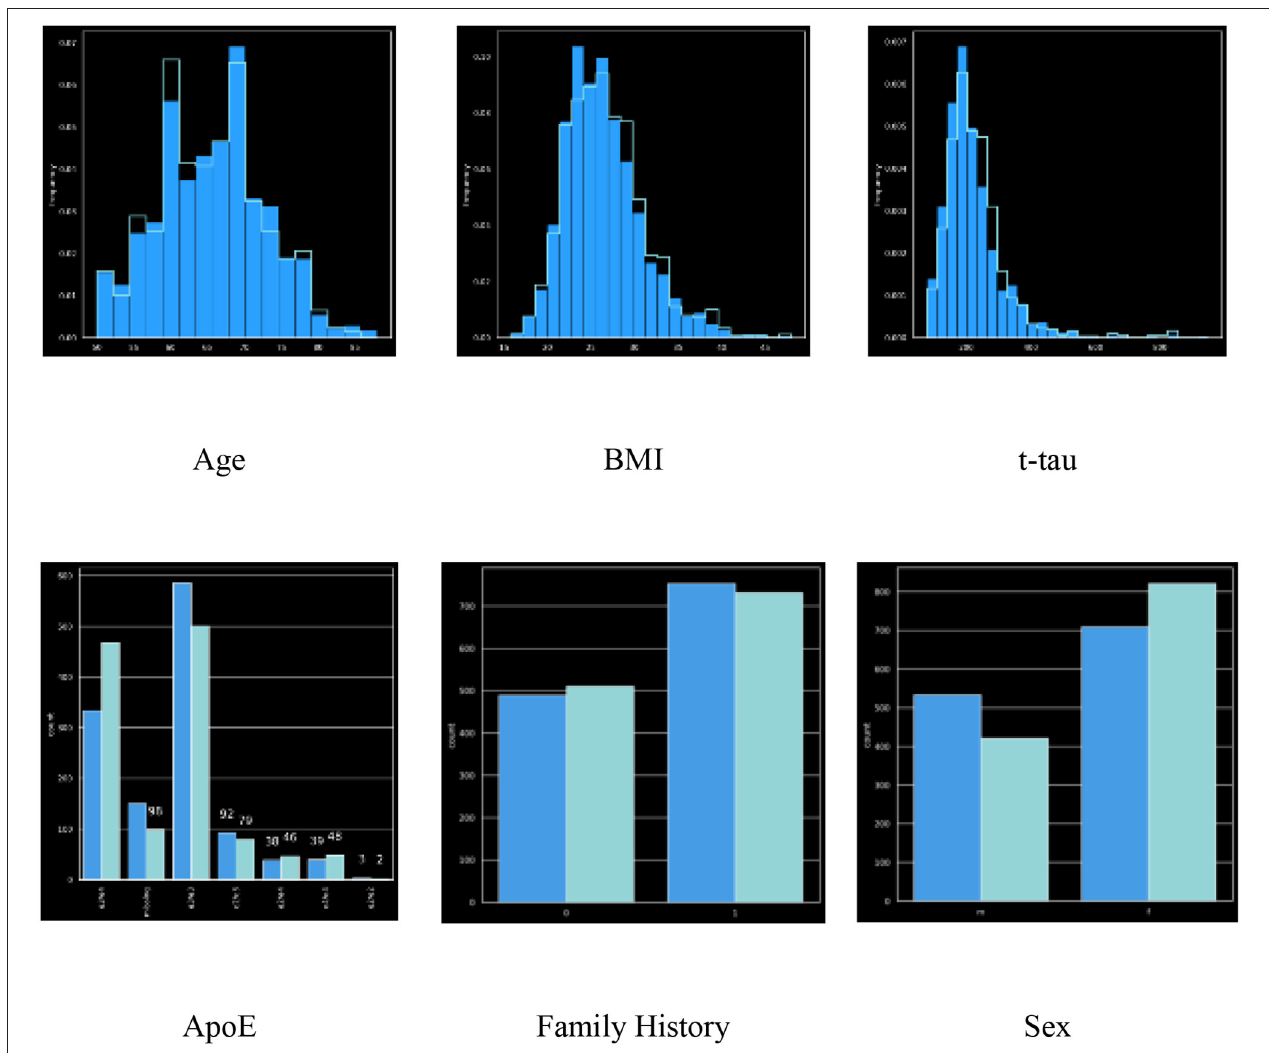
FIGURE 1 | Univariate distributions of Age, BMI, t-tau, ApoE gene, Sex, and family history.